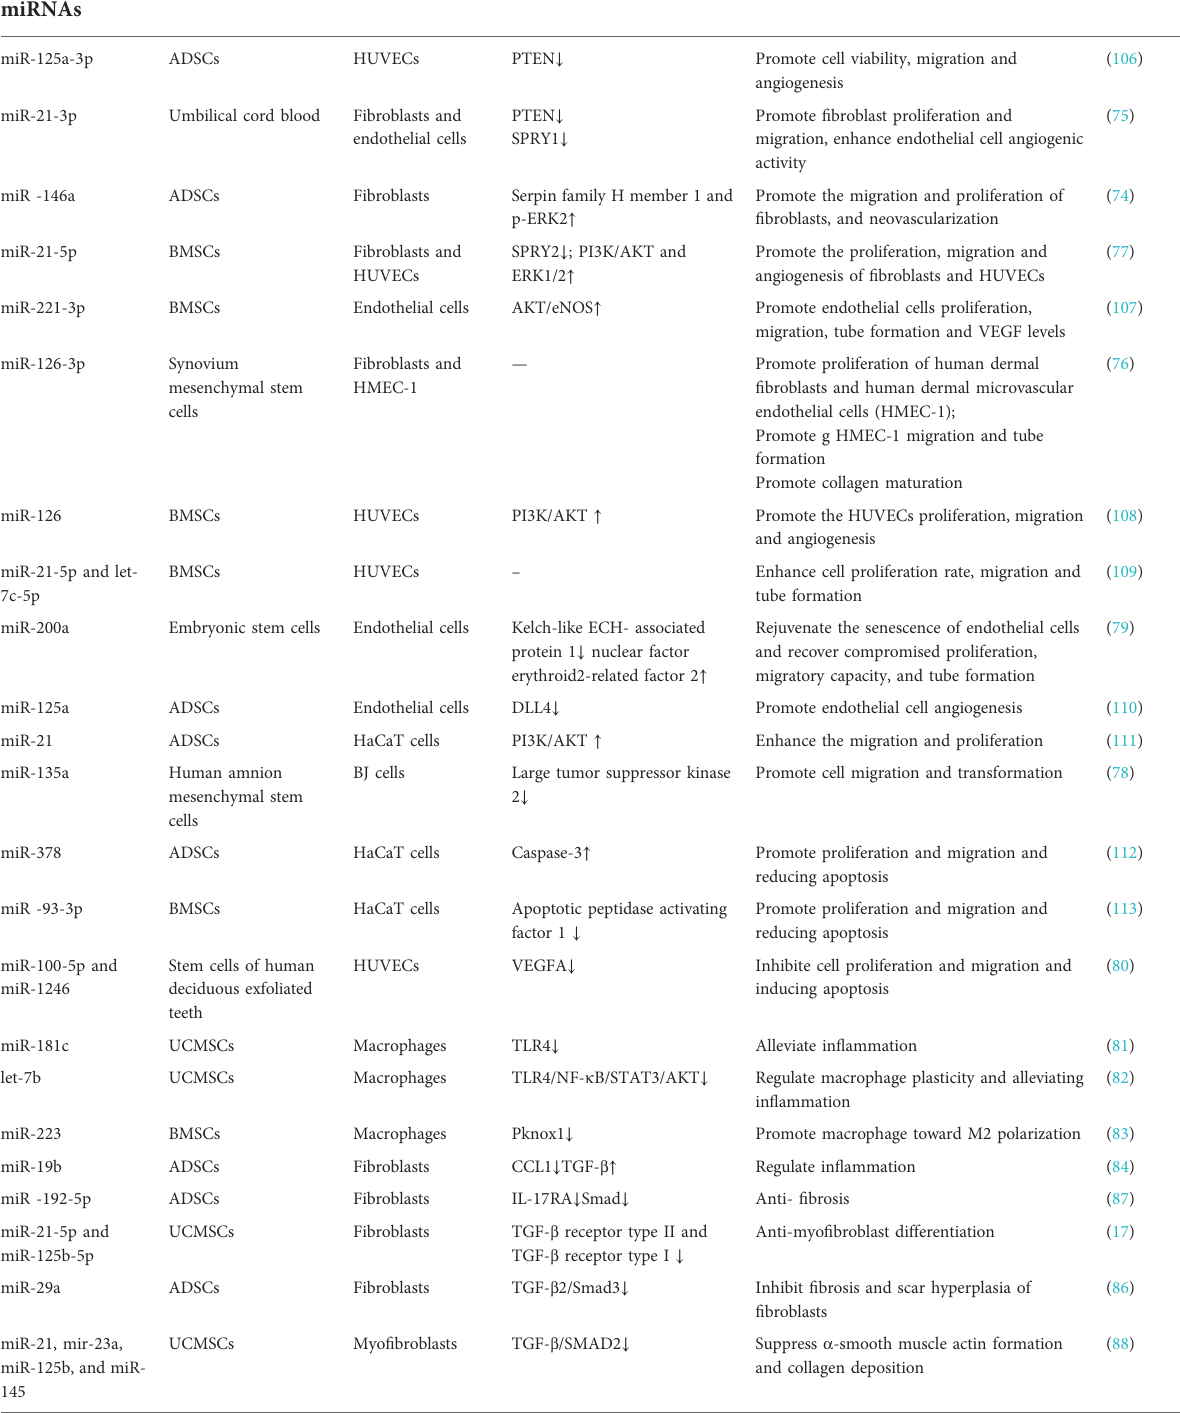
TABLE 1 Stem cell-exosome derived miRNA-mediated regulation of wound